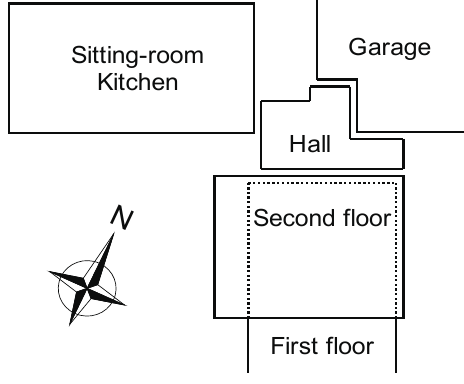
Figure 2. Floor plan and thermal zones of the dwelling.